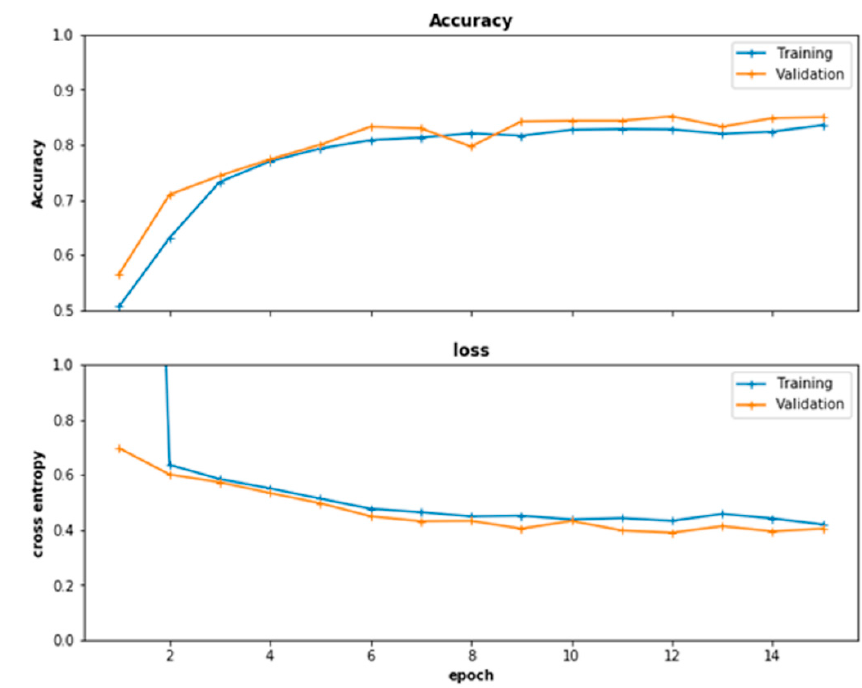
Figure 18. Accuracy graph before fine-tuning. Table 8. Configuration details and number of parameters. Model: “sequential”.